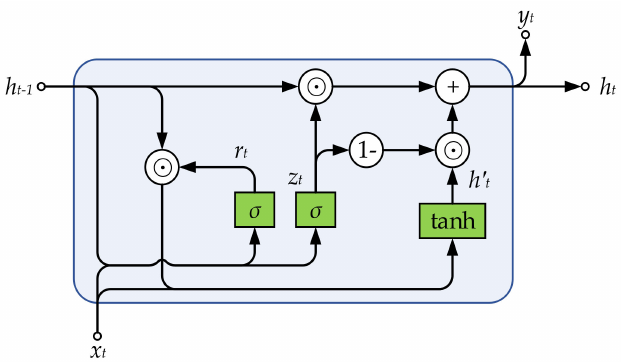
Figure 3. Structure of the GRU